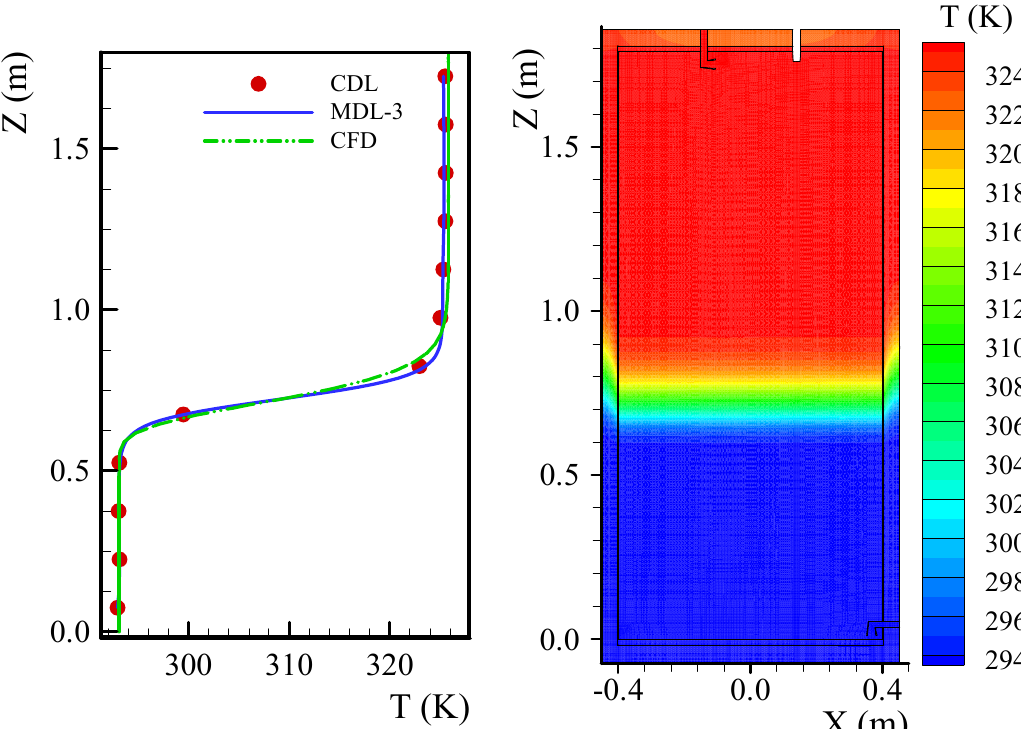
Figure 6. Left side : Instantaneous temperature profile at t* = 0.5734 obtained for CD at low flow rate with MDL-3 model (blue line), the CFD model (green dashed line) and the experimental data (CDL, red marker). Right side : Temperature distribution also at t* = 0.5734 and for CD at low flow rate, obtained with CFD.